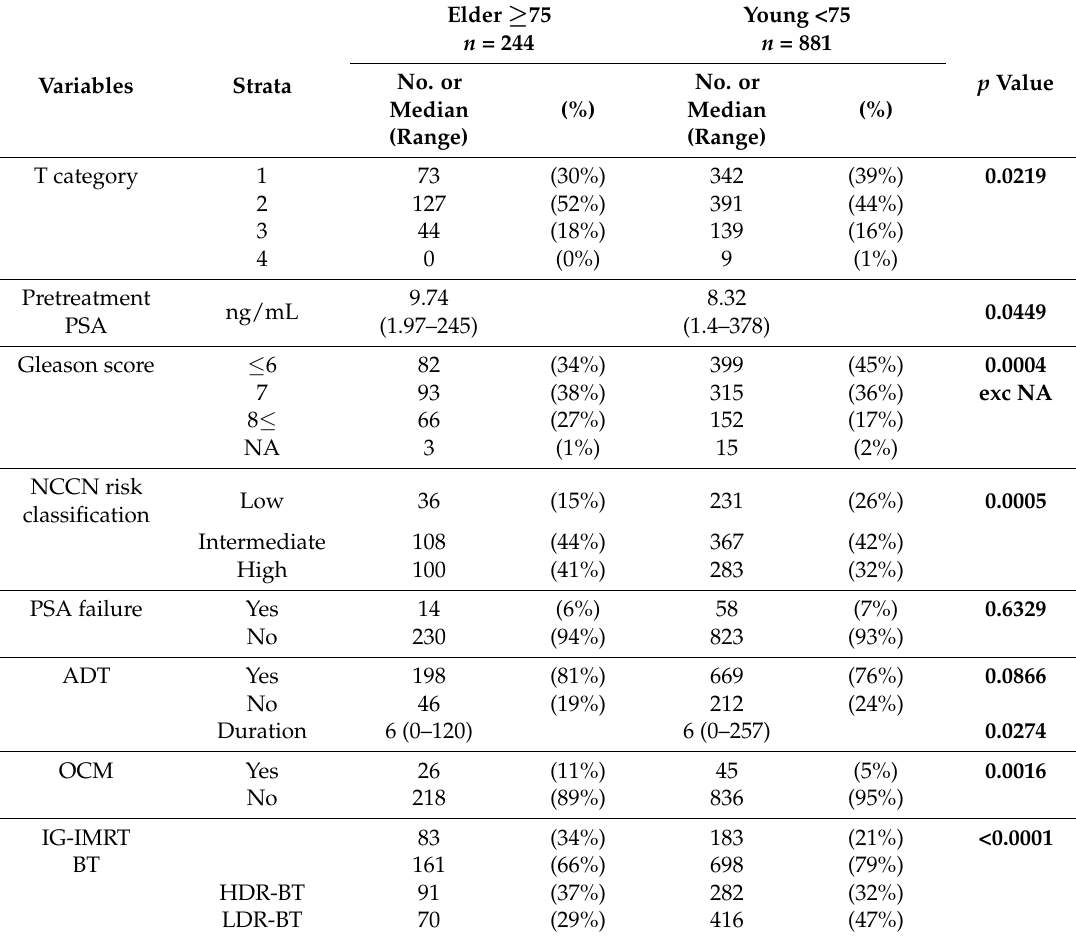
Table 5. Characteristics and treatment factors of elder patients and younger